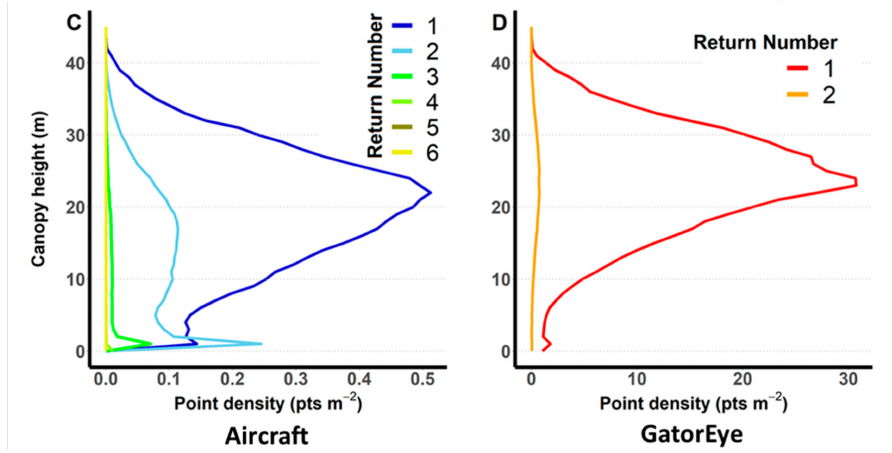
Figure 2. ( A , B ) GatorEye (red) and Aircraft (blue) LiDAR point density (pts m − 2 ) and distribution (% per 1 m vertical zone) vertical profiles. ( C ) Vertical profile of point density for all returns for aircraft (1–6) and ( D ) for GatorEye (2). Remote Sens. 2020 , 12 , x FOR PEER REVIEW